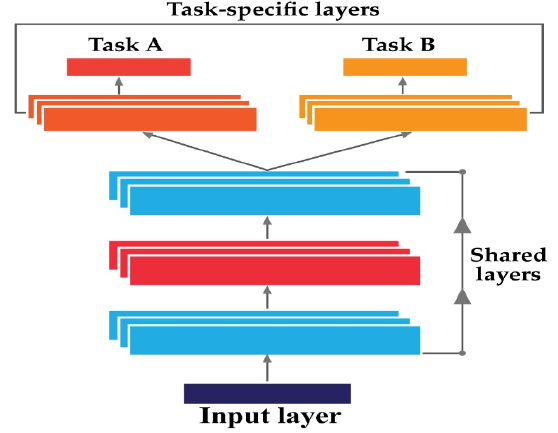
Figure 2. The basic concept of a multi-task learning neural network.